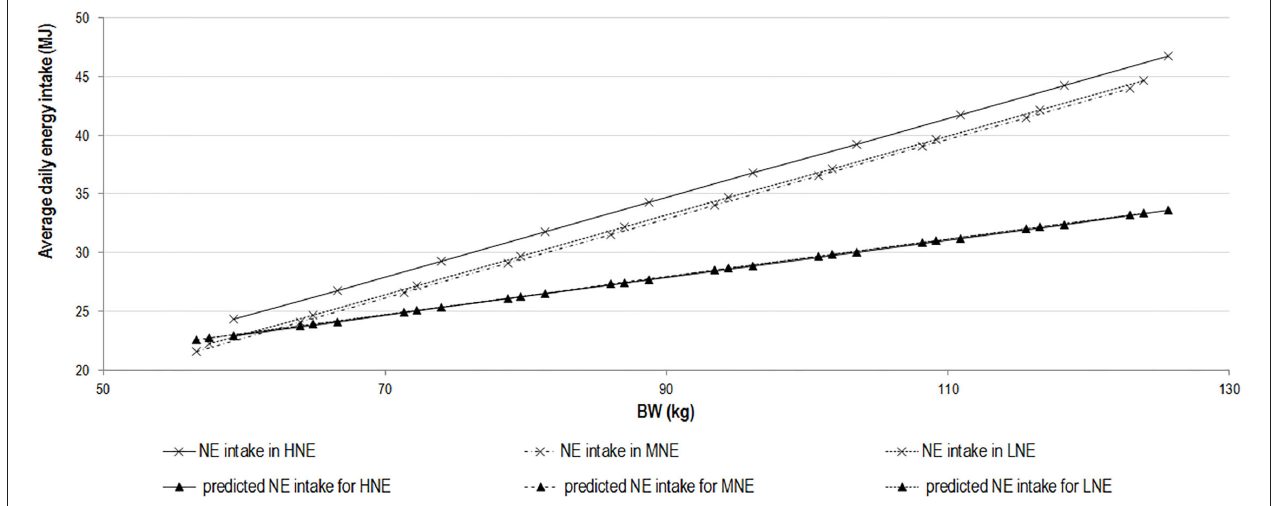
FIGURE 2 | Relationship between daily net energy intake and body weight of growing–finishing immunocastrated pigs. Relationship between daily net energy (NE) intake and body weight of growing–finishing immunocastrated pigs (vaccinated with Improvac ® , Zoetis at the age of 77 and 112 days) on experimental diets containing 10.4 (LNE) and 11.0 (MNE) MJ/kg of DM in comparison with the standard diet containing 11.6 (HNE) MJ/kg of fed diets. Predicted NE intake was calculated as 4.09 × BW 0.43 . LNE, low NE; MNE, medium NE; DM, dry matter; BW, body weight.